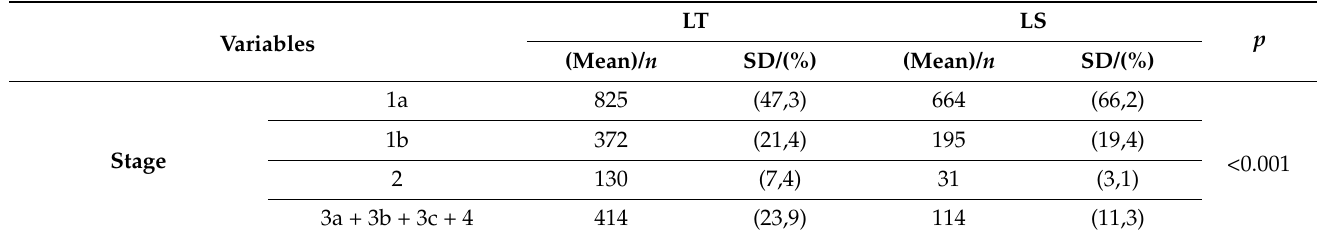
Table 2. Histopathological features of the